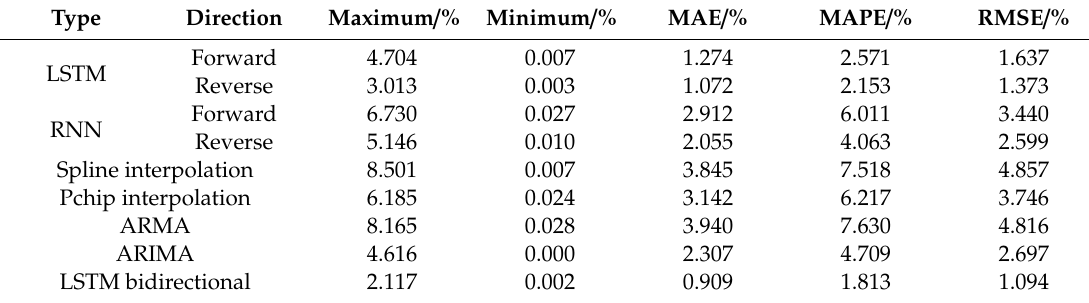
Figure 11. Filling results for different methods (LSTM, RNN, interpolation, LSTM bidirectional). Table 5. Comparison of error statistical results.